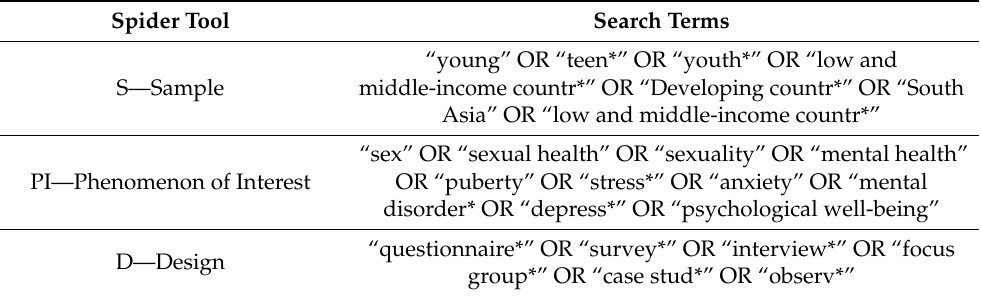
Table 2. Mapping Keywords using the SPIDER Tool. Spider